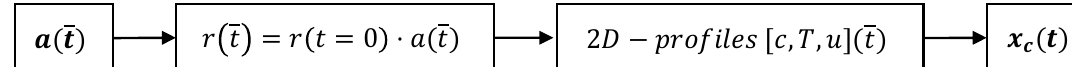
Figure 19. Scheme of the simplified modelling strategy to consider the influence of the catalyst activity on coke formation.